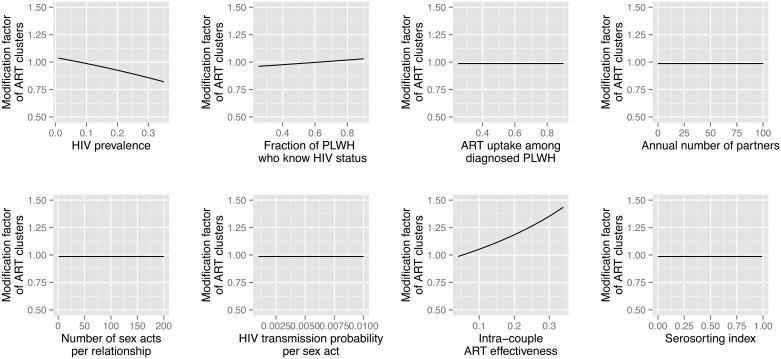
Effects of model parameters on the modification factor of the impact of ART associated with ART homophily.Notes: The modification factor is calculated by dividing the estimated impact of ART in a context with perfect ART homophily (m = 1) by the estimated impact of ART in a context without any ART homophily (m = 0).